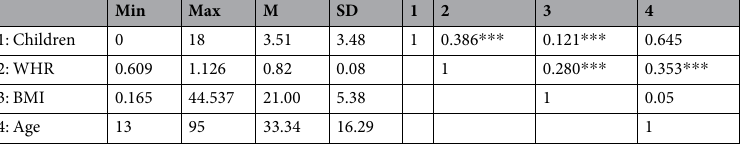
Table 1. Descriptive Statistics and Intercorrelations between Study Variables. Note . N = 925. Children = the number of children, WHR = waist-to-hip-ratio, BMI = body-mass index. *** p <